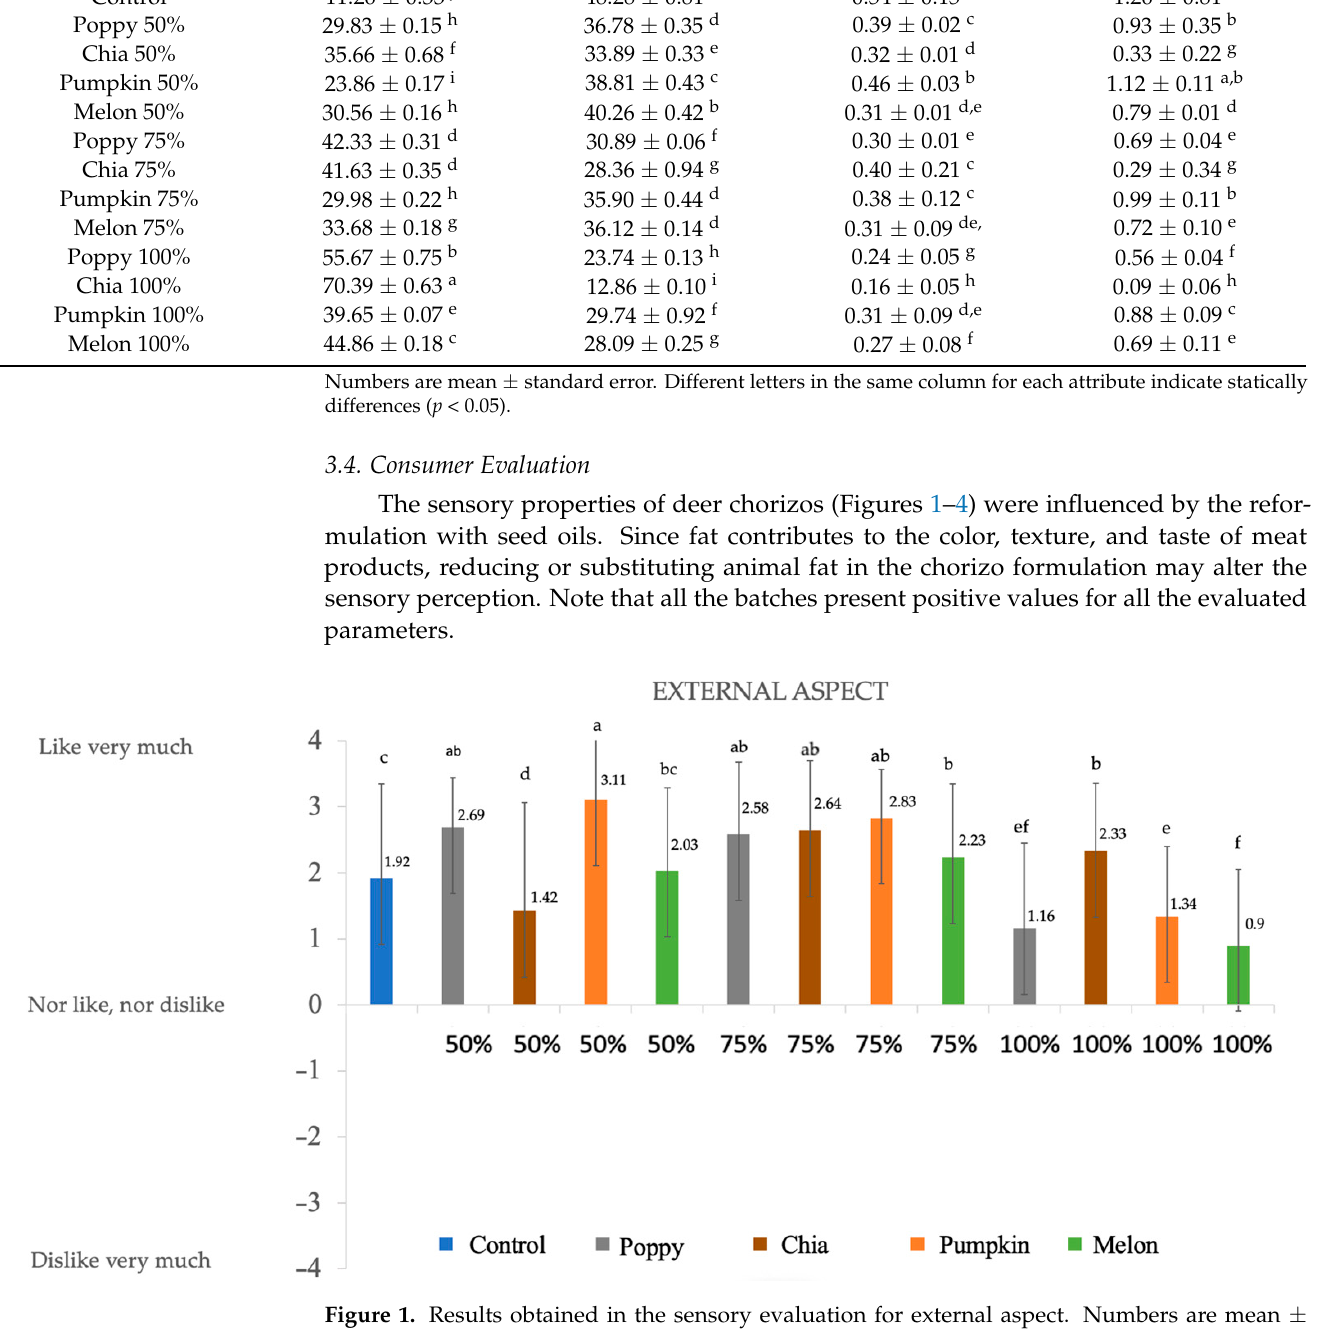
Figure 2. Results obtained in the sensory evaluation for texture. Numbers are mean ± standard error. Different letters in the same column for each attribute indicate statically differences ( p < 0.05).